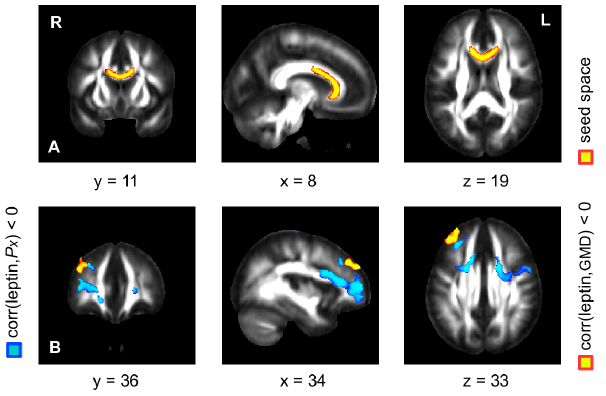
Figure 4. Correlation between serum leptin concentration and connection probability Px. Probabilistic fiber tracking was performed using a seed mask in the anterior corpus callosum ( A ; color-coded in yellow). Higher serum leptin concentrations were associated with smaller connection probabilities between the anterior corpus callosum and prefrontal WM regions ( B ; color-coded in blue). Significant correlation was detected using randomization tests with a significance level of p , 0.01. The detected prefrontal WM regions are located in the vicinity of the observed GM regions showing a negative correlation between leptin level and GMD ( B ; yellow color; see also Figure